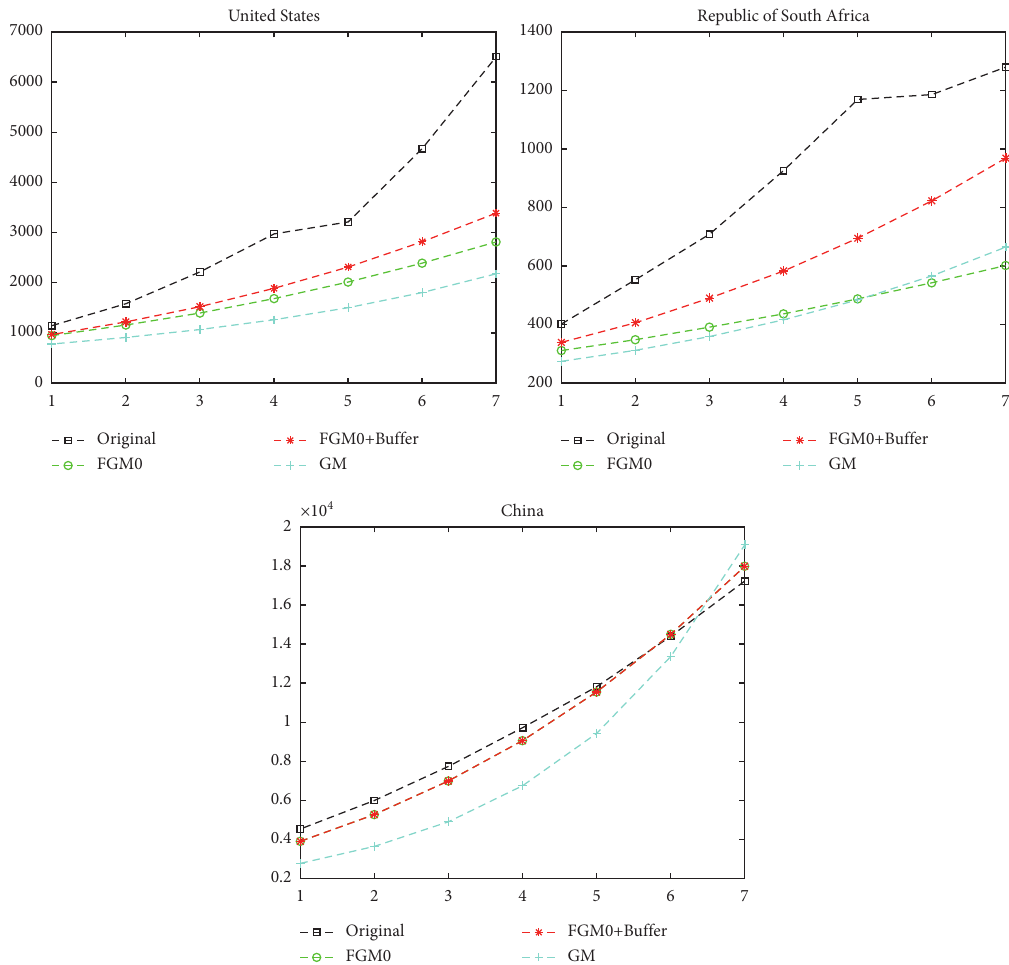
Figure 3: The prediction performance in the early stage (part 2).